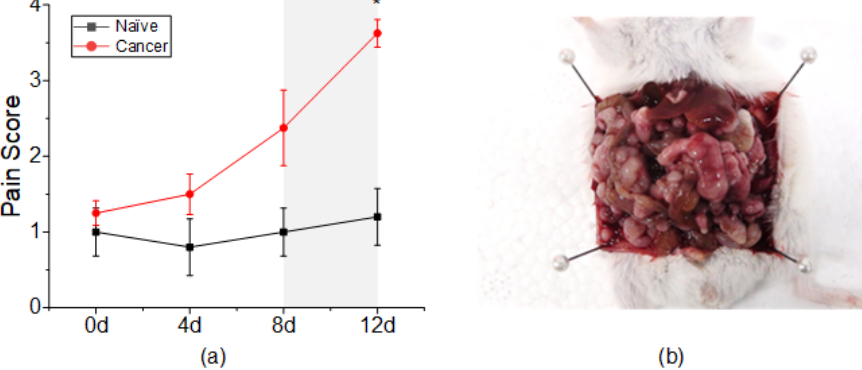
Figure 2. Pain assessment of naïve and cancer groups. ( a ) The pain score in the cancer group was significantly increased at day 12 compared to that in the naïve group. ( b ) Representative image of tumor formation at 12 days after CT-26 injection. * p < 0.05 vs. naïve.